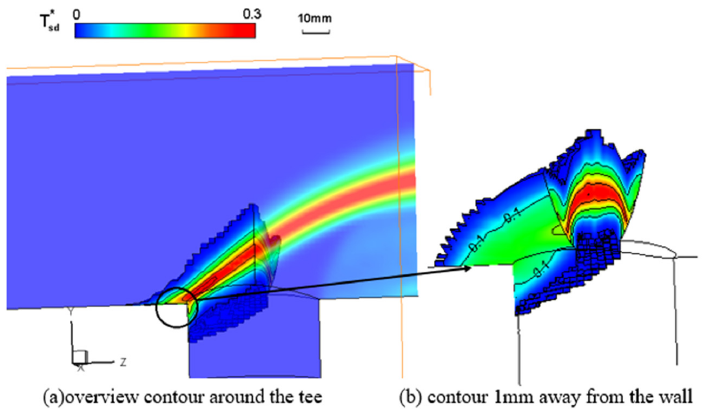
Figure 11. Temperature fluctuation intensity distribution in the plane of X = 0 of the W-ref case.